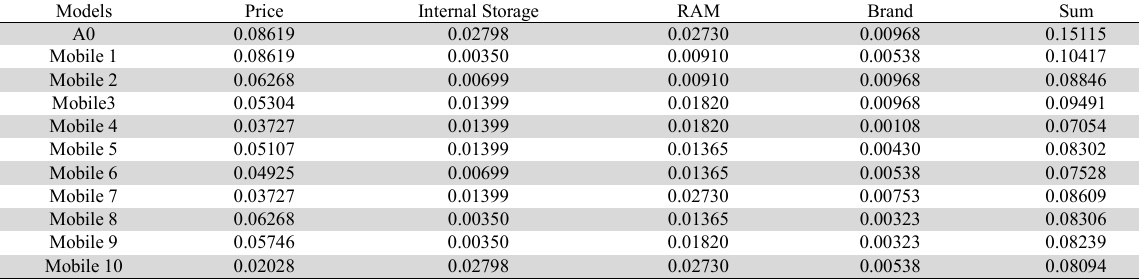
Weighted Normalized Decision Matrix